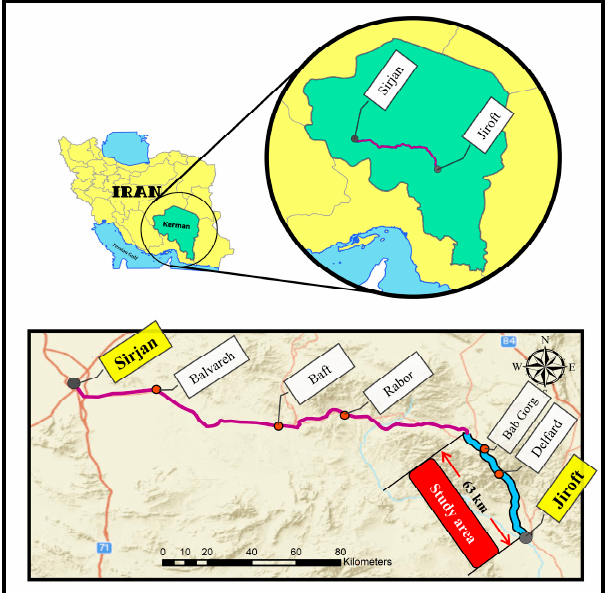
Figure 2. The study area in Kerman Province, Iran.